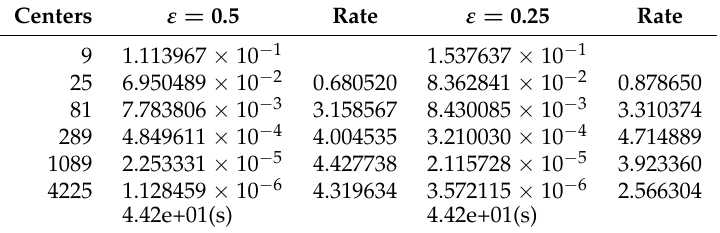
Table 1. Compactly supported radial basis function (CSRBF) interpolation: